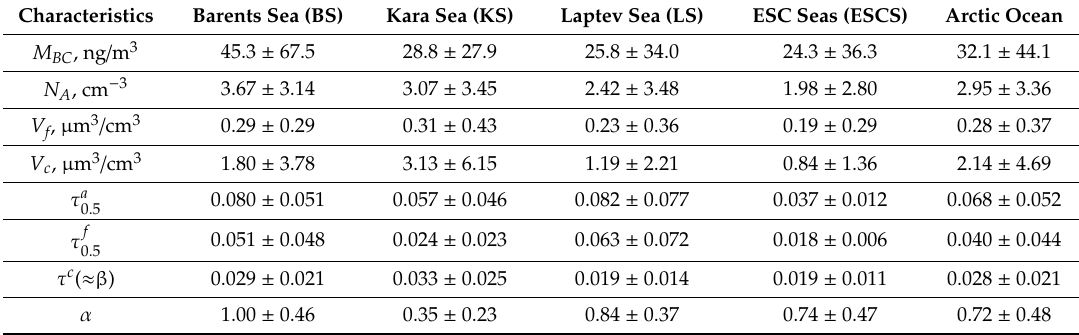
Table 3. Average values and standard deviations ( ± SD) of aerosol characteristics over the Arctic seas